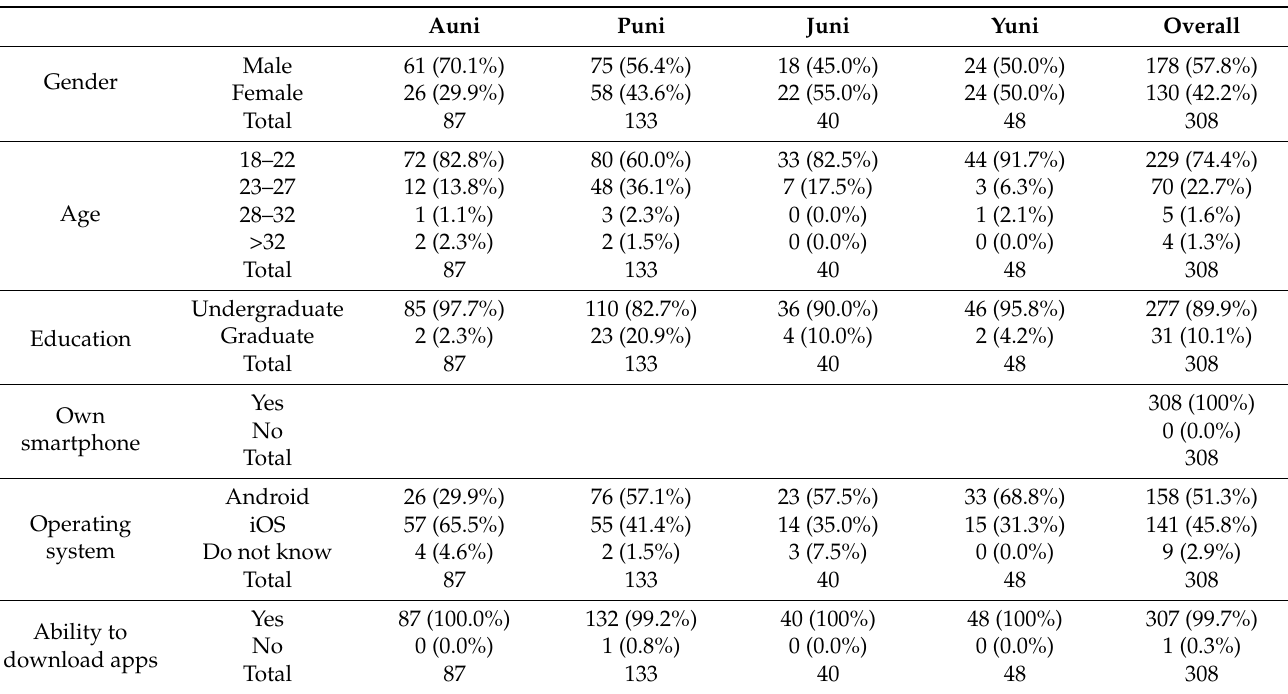
Table 2. Demographic and sample information.